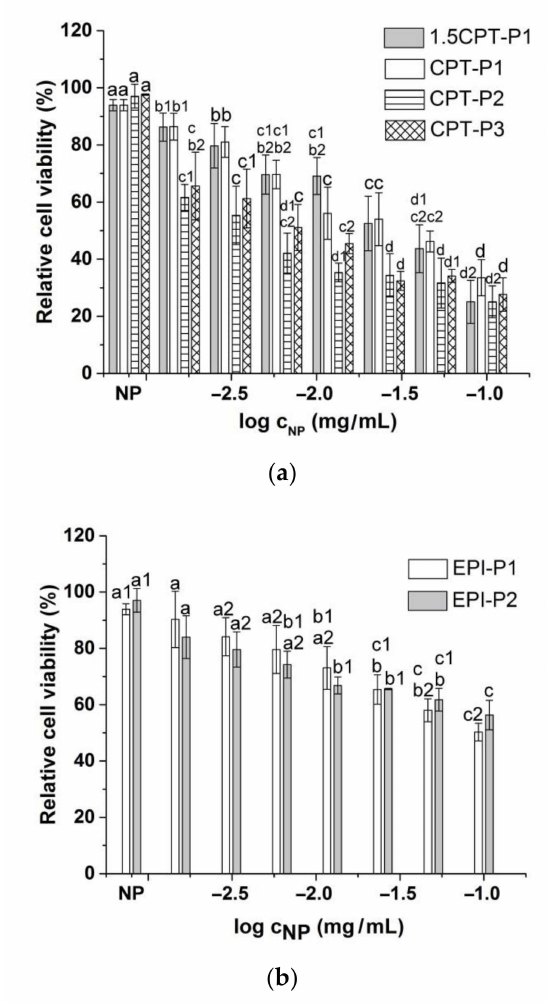
Figure 6. Viability of MCF-7 breast cancer cells treated with ( a ) CPT-loaded polyphosphazene nanoaggregates and ( b ) EPI-loaded polyphosphazene nanoaggregates. NP stands for blank polyphos- phazene nanoaggregates at 0.1 mg/mL (see structures in Figure 1). Viability was normalized to the untreated control. Data represent the mean ± standard deviation ( n = 3). Means with no significant differences are presented with the same letter ( p > 0.05). Means with significant differences are presented with different letters or the same letter but different numbers following the letter ( p <